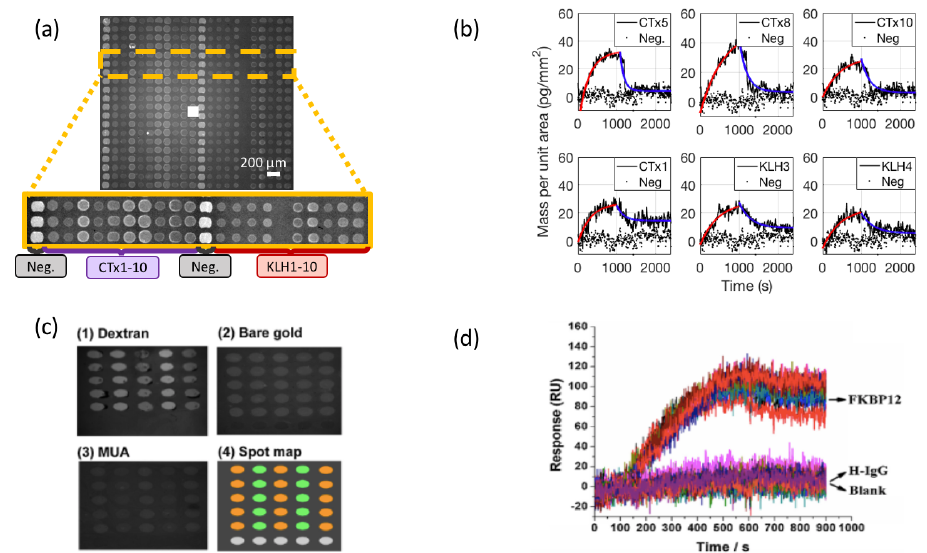
Figure 6. Small molecule characterization on the IRIS ( a , b ) and on the SPRi sensor ( c , d ). ( a ) Image obtained on the IRIS instrument for a multiplexed microarray spotted with 20 antibodies against fumonisin B1. The labels indicate the different antibodies immobilized on the surface ( b ) Set of six binding curves for fumonisin to the multiplexed surface acquired on the IRIS. The black lines (dotted and solid) represent the acquired data, while the red and blue line indicate the 1:1 association and dissociation Langmuir fit. ( c ) Image obtained on SPRi of an antibody microarray against FK506 spotted on different surfaces. The (1–3) insets shows SPRi images of the spots on a different surface chemistry, while inset (4) shows the spotting scheme. ( d ) Binding curves of FK506 acquired on SPRi. The arrows indicate which spots the data are obtained from. Parts ( a , b ) were adapted with permission from [20] (Copyright 2020 American Chemical Society). Parts ( c , d ) were adapted with permission from [115] (Copyright 2015